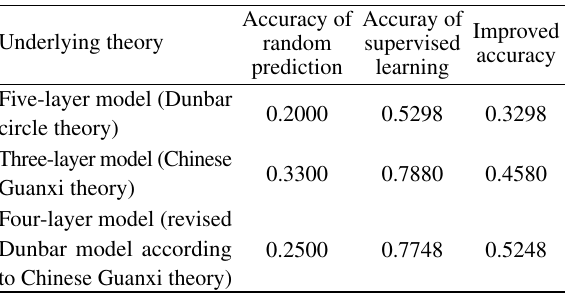
Table 5 Comparison of the highest accuracy of different